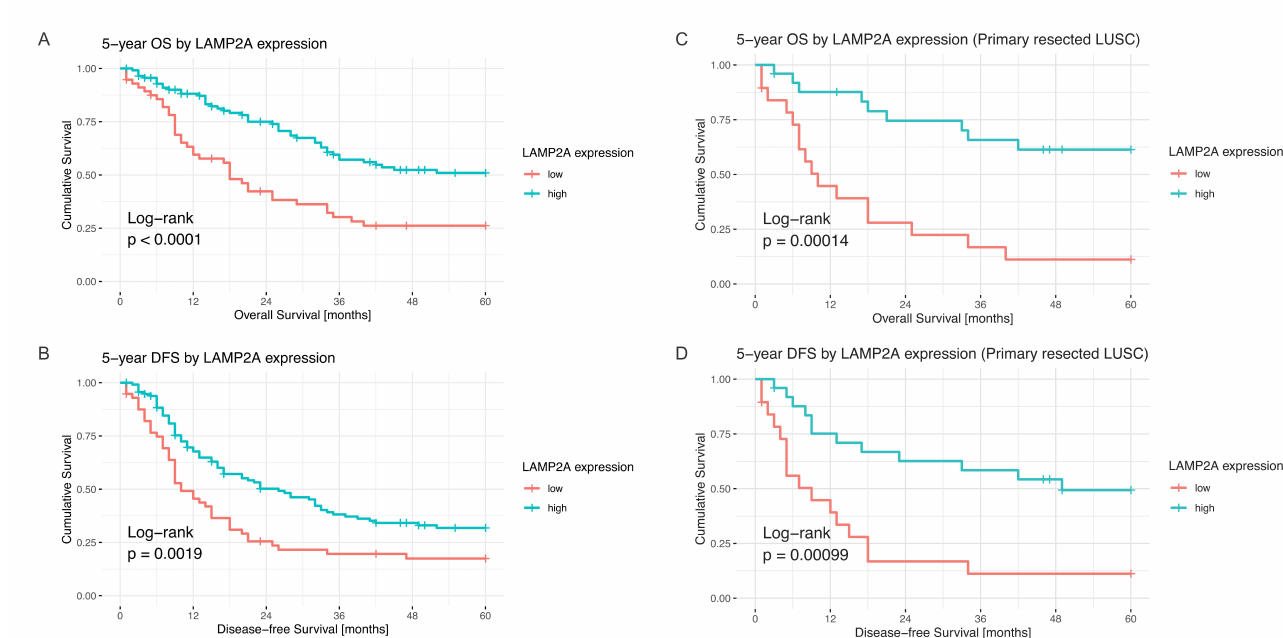
Figure 4. Survival curves for LAMP2A, ( A ): OS, overall; ( B ): DFS, overall; ( C ): OS, LUSC subgroup; ( D ): DFS, LUSC subgroup.